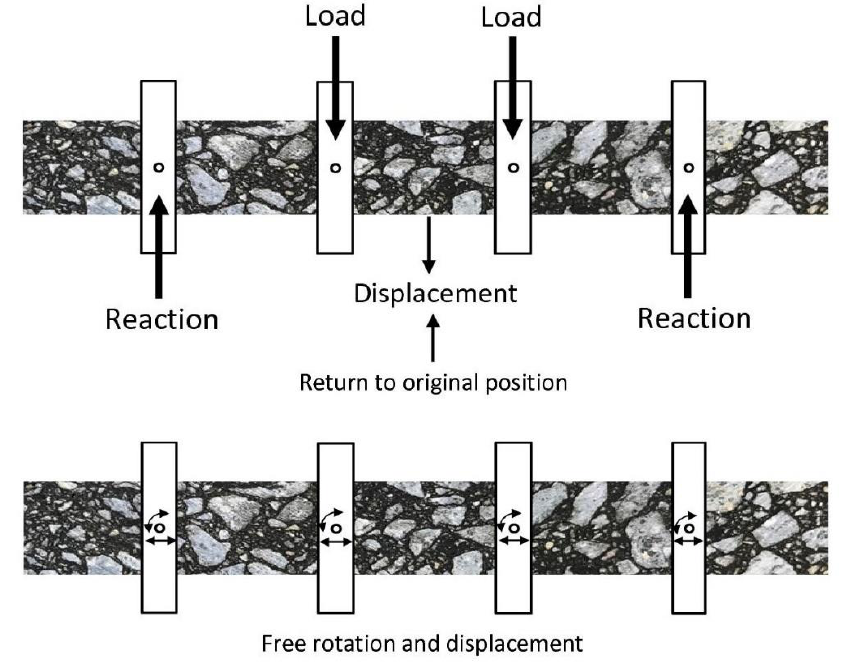
Figure 10. Schematic representation of the asphalt concrete prismatic beam specimens clamped on the test machine.